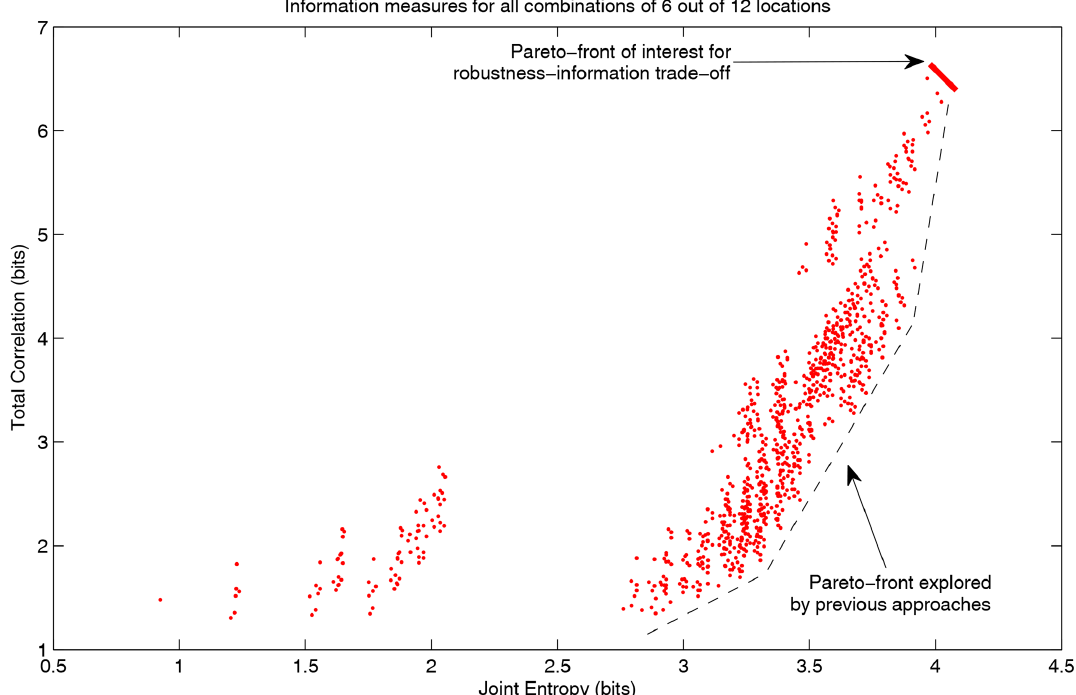
Figure 8. The resulting total correlation and joint entropy for all 924 possible combinations of 6 out of 12 sensor locations. In some past approaches, a Pareto front in the lower right corner is given importance. In this paper, we argue that this trade-off is irrelevant, and information can be maximized with the horizontal direction only. If a trade-off with reliability needs to be considered, the Pareto front of interest is in the top-right corner instead of the lower right corner that is previously recommended in the